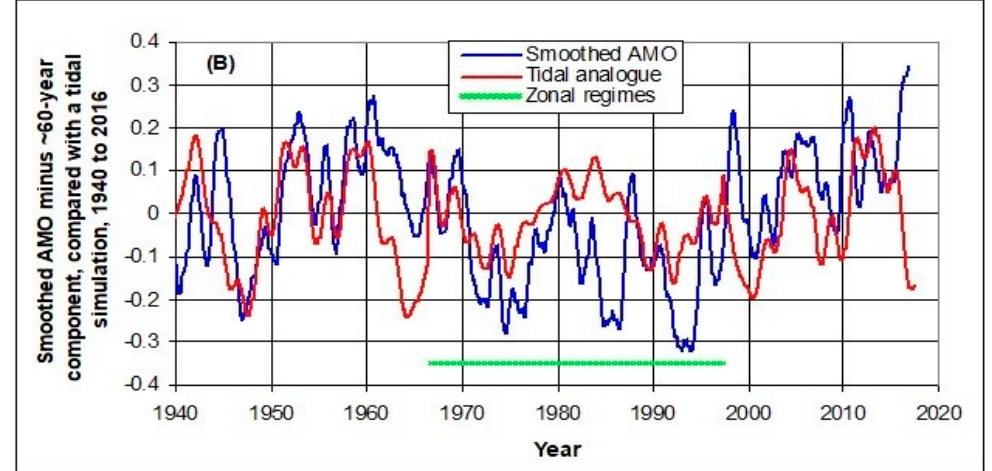
Figure 11. A simulation of the AMO over the time segments: ( A ) 1856–1940; and ( B ) 1940–2016, after removing the ~60-year oscillation captured by F(t), and then smoothing with a 13-month running mean. These are compared with a tidal analog, for an AMO lag time of 0.04 years with respect to the tidal analog. The tidal components are listed in Table 13.